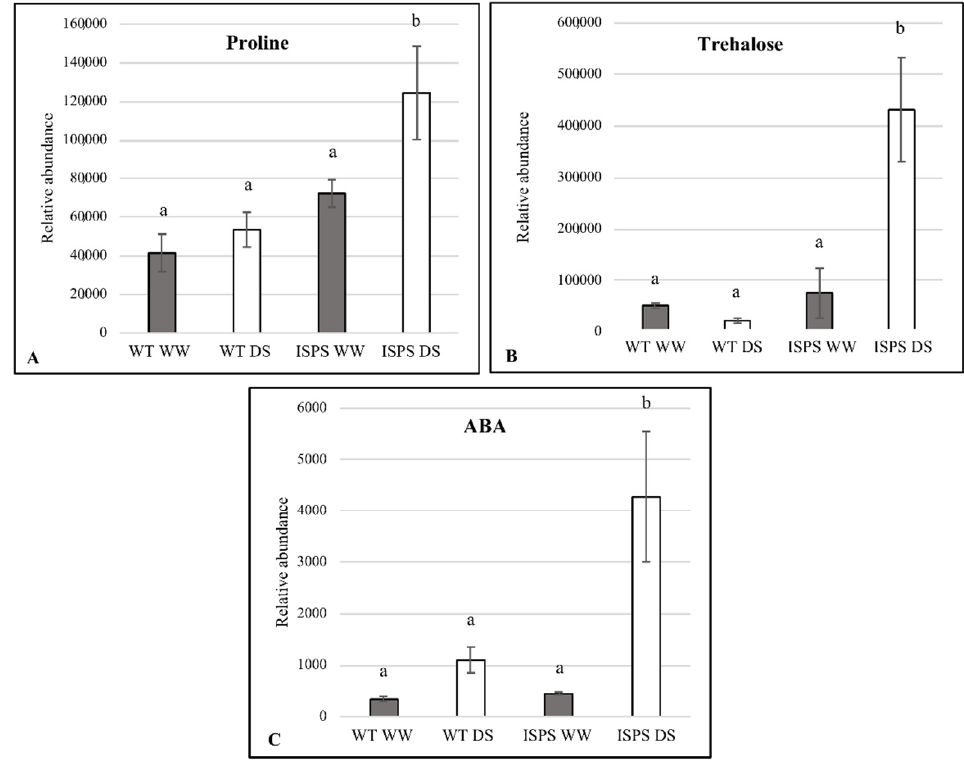
Figure 5. Proline ( A ), trehalose ( B ) and ABA ( C ) content in WT and ISPS genotypes under well- watered (grey column, WW) and water-stress (white column, DS) conditions. Different lowercase letters indicate significant differences at the p < 0.05 level using Kruskal-Wallis test and Dunn post-hoc comparisons method.